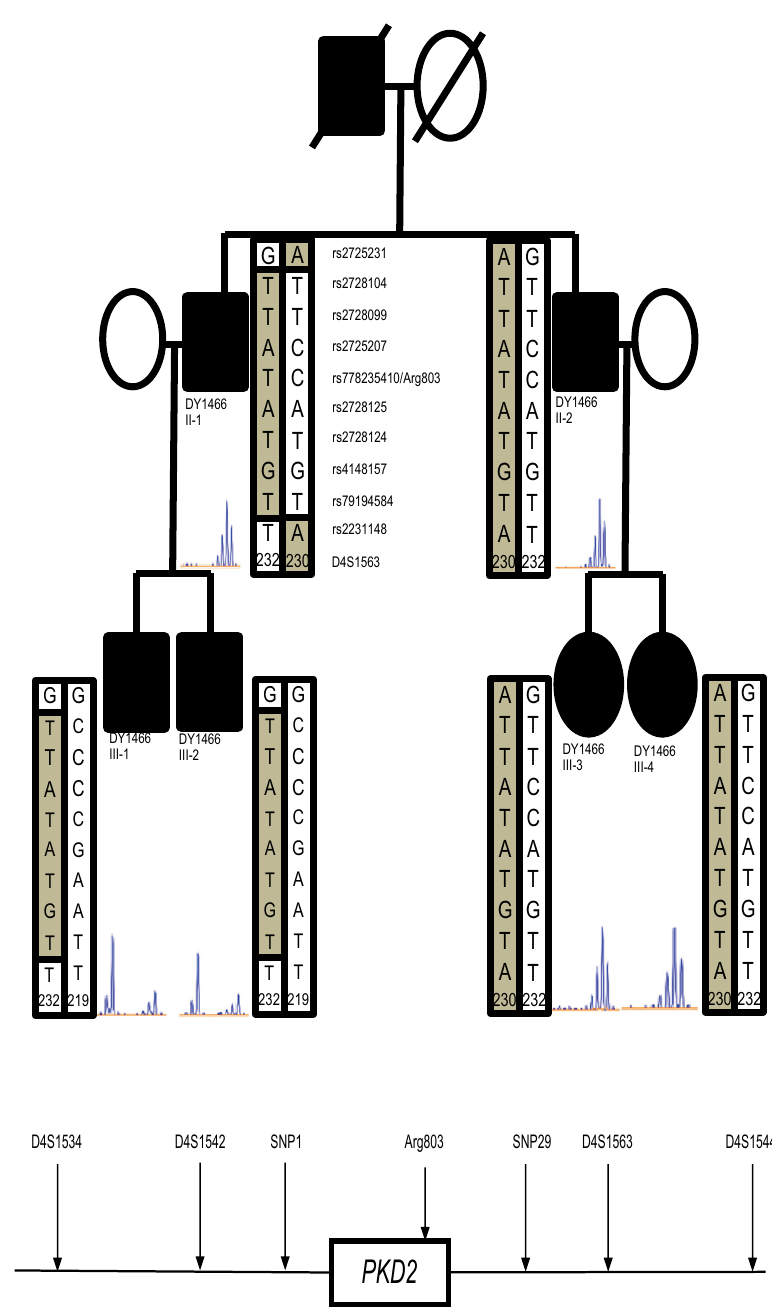
Fig. 4 Genetic recombination of the PKD2 region in family DY1466. a In family DY1466 with 6 PKD2 R803* affected individuals, members III- 1 and III-2 were found to carry different microsatellite markers and haplotypes. They had only 72 kb (10 SNPs) within this 250 kb region that was the same as their father. b Although II-1 and II-2 carried the common R803* haplotype along with the D4S1563 marker, gene recombination most likely occurred in individual II-1, with a 72 kb allele crossover leading to both of his children having the PKD2 p.R803* mutation but different